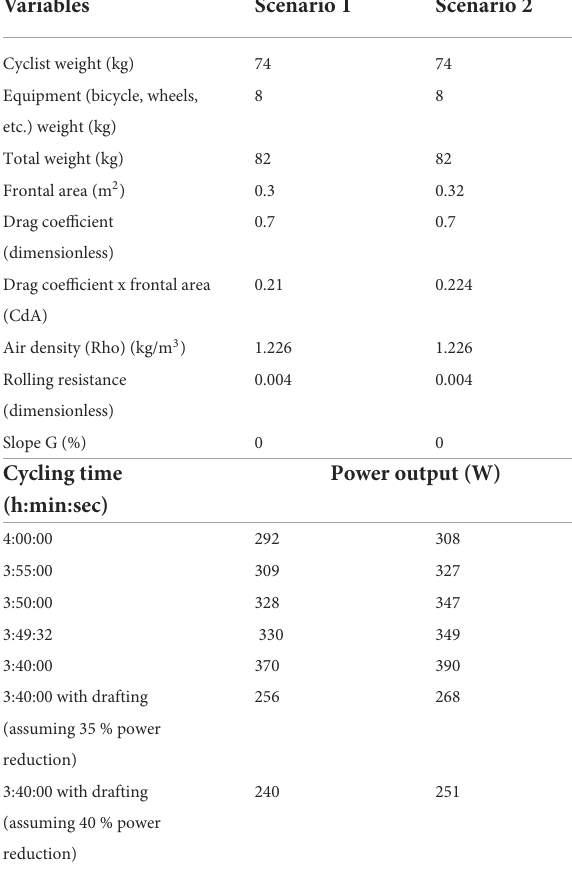
TABLE 8 Yearly fastest Ironman TM running times between 2005 and